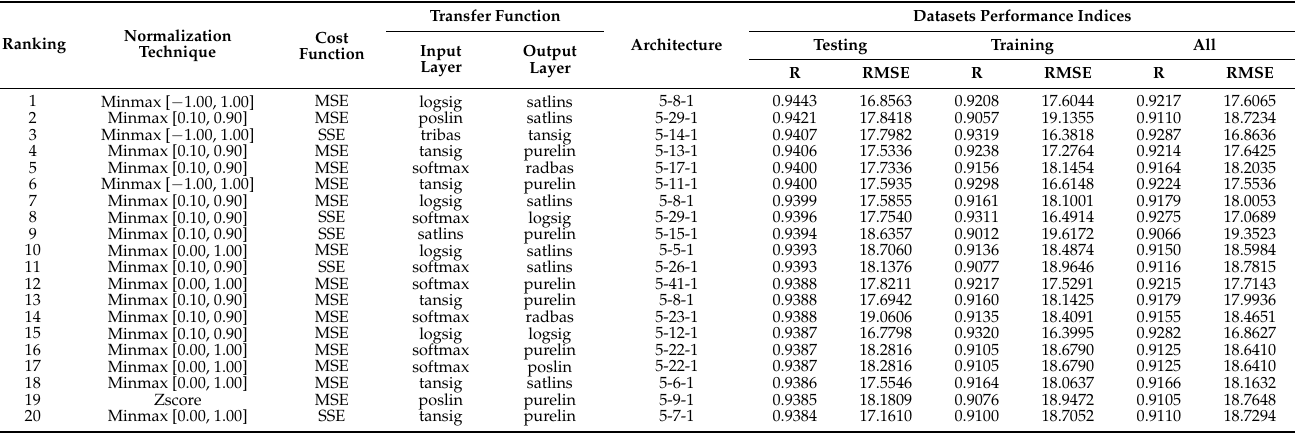
Table 6. Architectures and hyperparameters of the top twenty developed ANN LM models based RMSE index and testing phase.